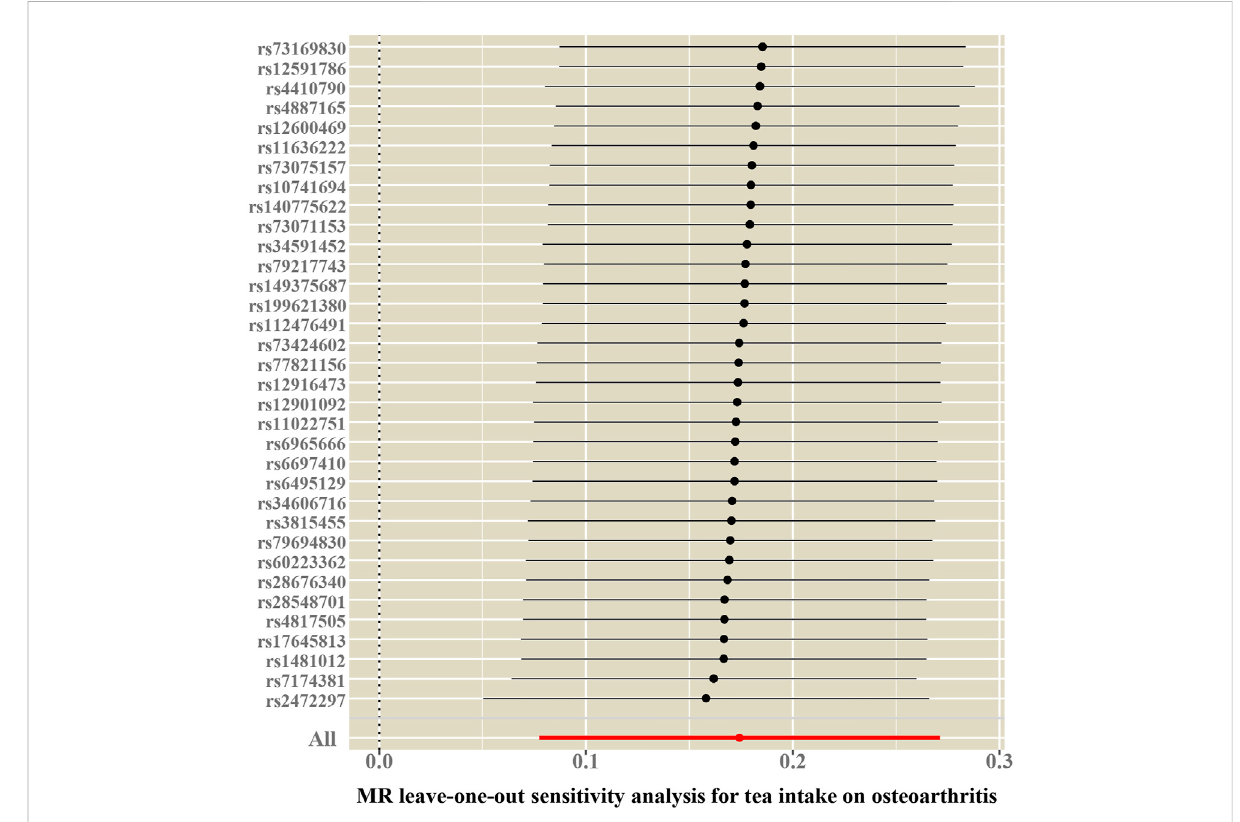
FIGURE 4 Leave-one-out sensitivity analysis for the causal association between tea consumption and